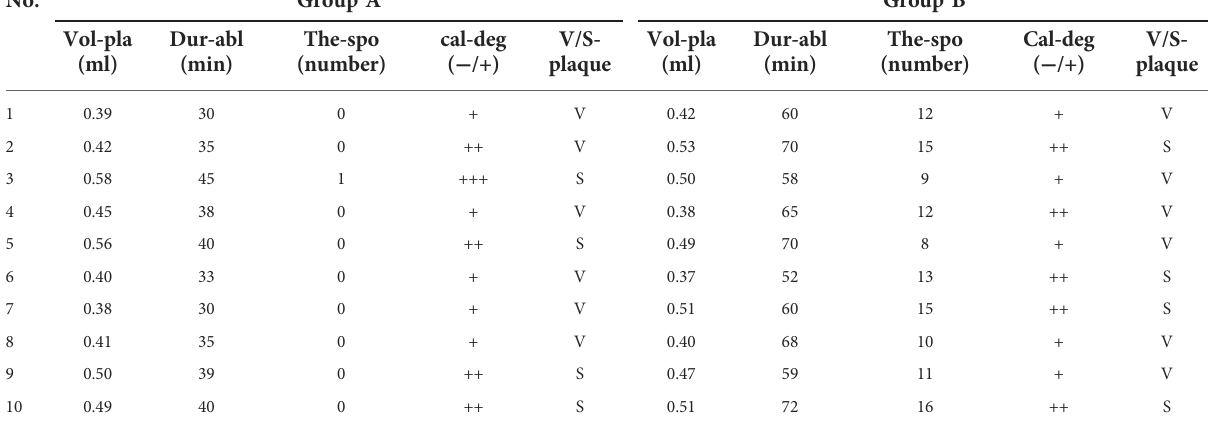
TABLE 1 Volume of plaques, duration of ablation, thermal injury spots, calci fi cation degree, and characters of plaques in Group A and B.